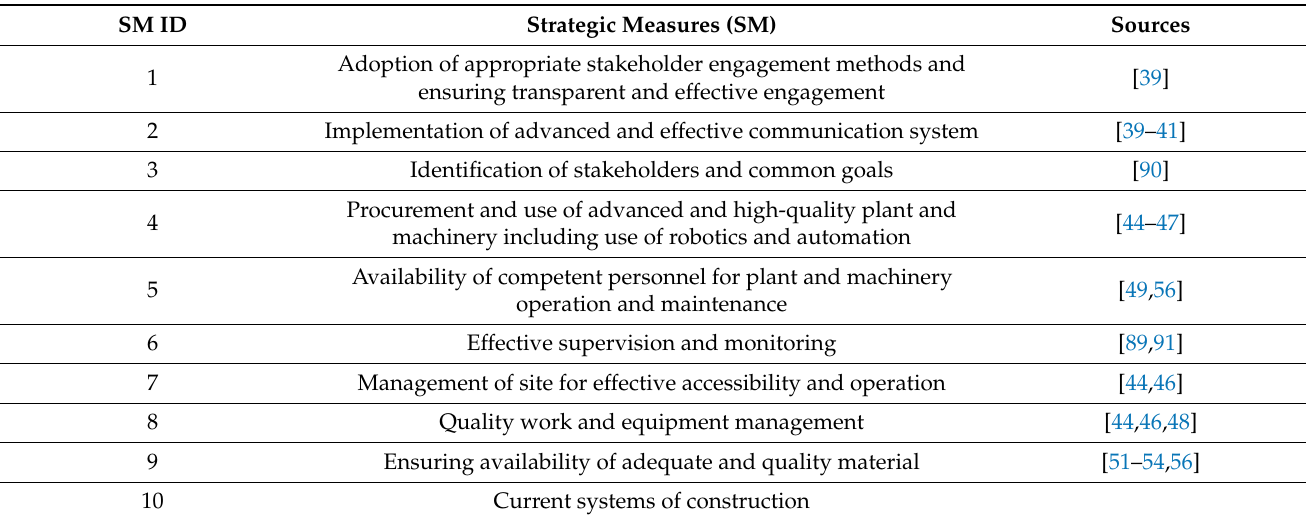
Table A2. Defining strategic measures for improving construction at sites in